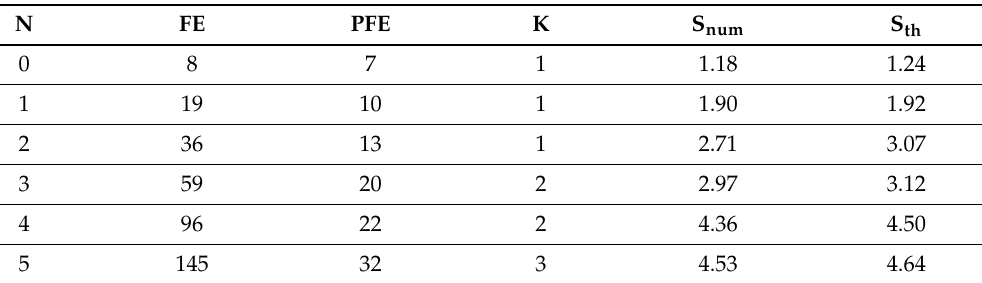
Figure 14. Dam break test case difference between FE and PFE schemes, for height h ( a ) and first moment α 1 ( b ), for varying N and constant ν = 0.1 and λ = 10 − 4 shows that the PFE method is the same in smooth regions and exhibits small differences in regions of large gradients as the FE method has a larger error there. Table 5. Dam break test case runtime (in sec) using FE and PFE schemes and speedup of PFE method for different N and constant n x = 1000, λ = 10 − 4 shows significant speedup close to the theoretical